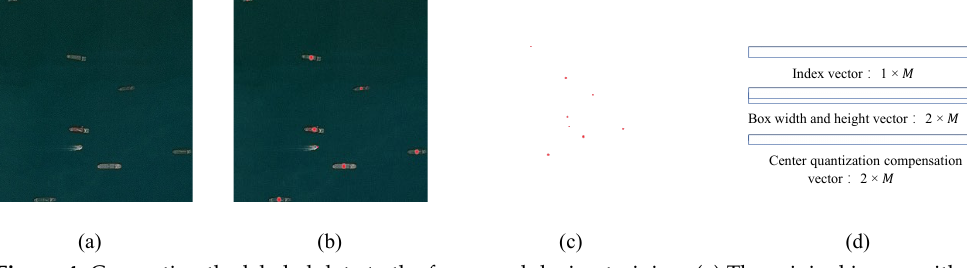
Figure 4. Converting the labeled data to the form used during training. ( a ) The original image with a height H and a width W . ( b ) Gaussian distribution at the center of the box, with a resolution of H × W . ( c ) The heat map of the center point; the resolution is 1 number of predicted